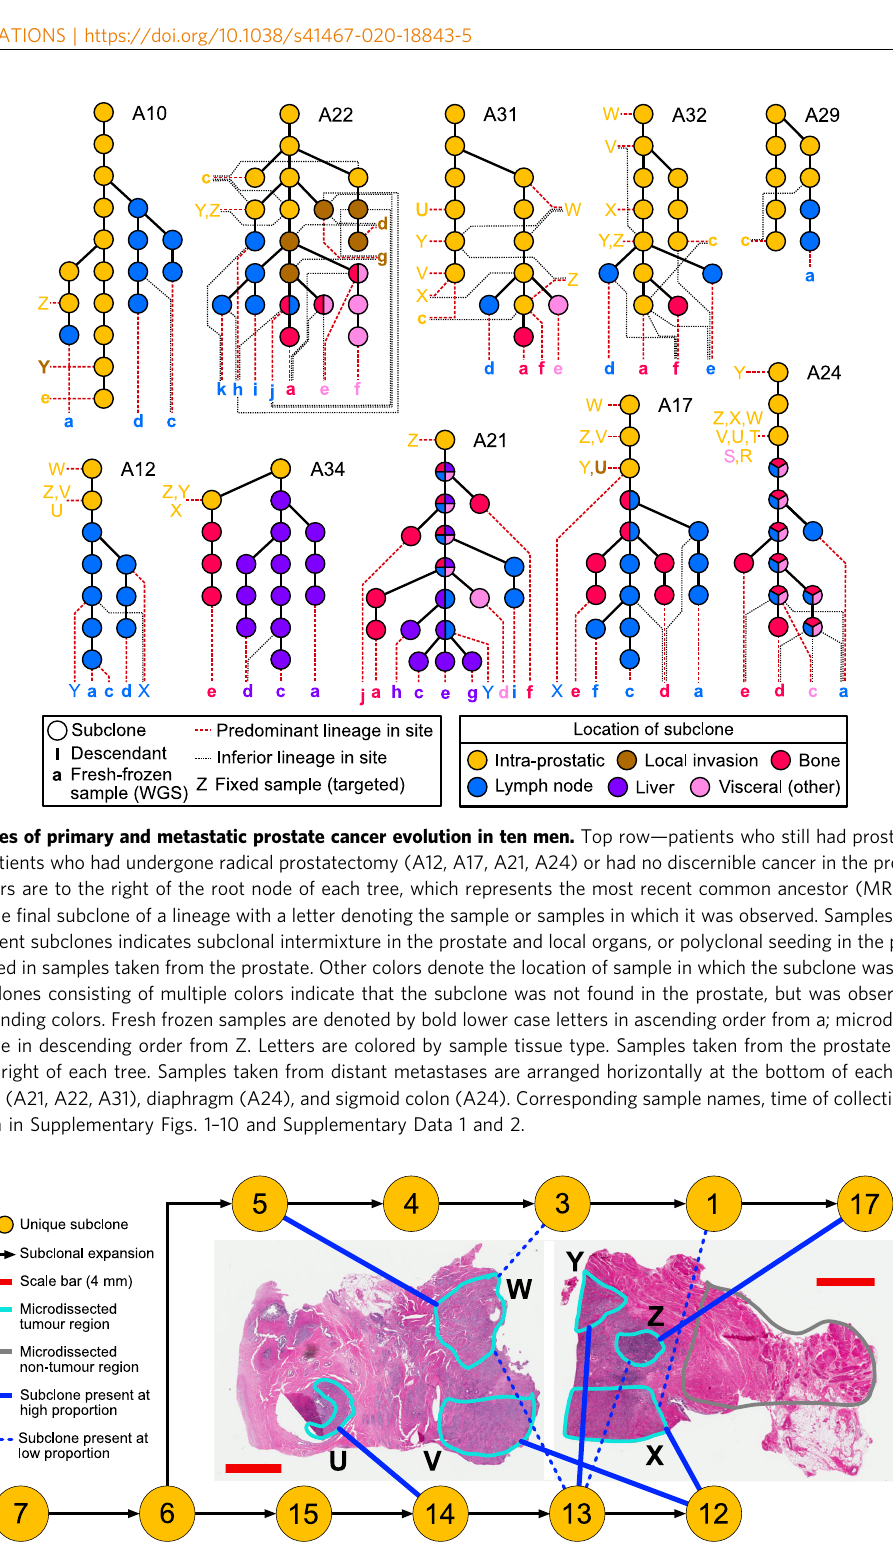
Fig. 2 Subclones from distinct lineages can be spatially intermixed within the prostate. Six samples were collected across two tissue blocks from adjacent regions of the prostate. The intra-prostatic portion of the phylogenetic tree of A31 is shown, with lines denoting the fi nal subclone of each distinct lineage found in the corresponding regions in each slide. Numbered subclones in yellow circles correspond to the clusters shown in Supplementary Fig. 8. Subclones that correspond to over 50% of tumor cells in a region are designated high proportion, all other subclones present are low proportion. Location of slides are given in Supplementary Fig.